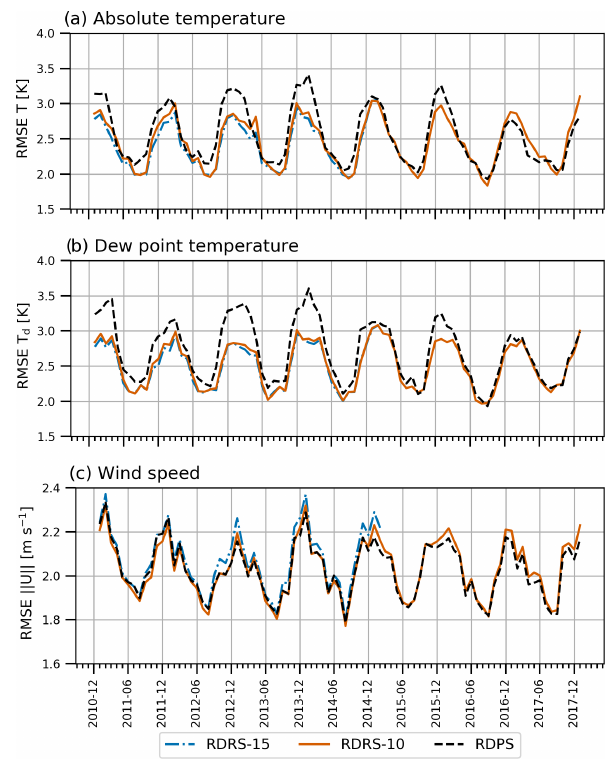
Figure 6. Time series of RMSE (against SYNOP observations) from operational RDPS (black dashed line), RDRS-10 (orange con- tinuous line) and RDRS-15 (blue dashed–dotted line) computed based on monthly intervals for the whole North America and the 2011–2017 years: (a) absolute temperature; (b) dew point temper- ature; (c) wind speed. Results only based on a combination of 6 to 17h lead time from integrations starting at 00:00 and